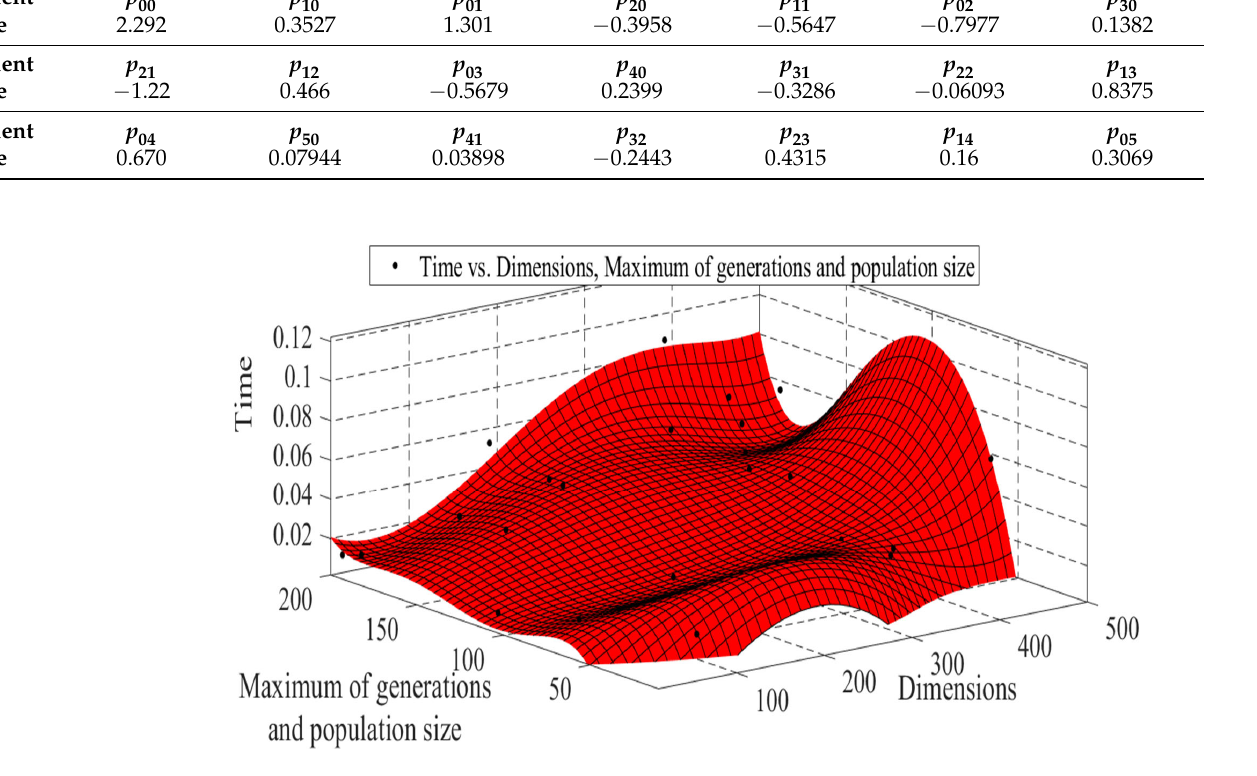
Figure 21. Calculations time of MRFO and PGA ‐ MRFO. 0